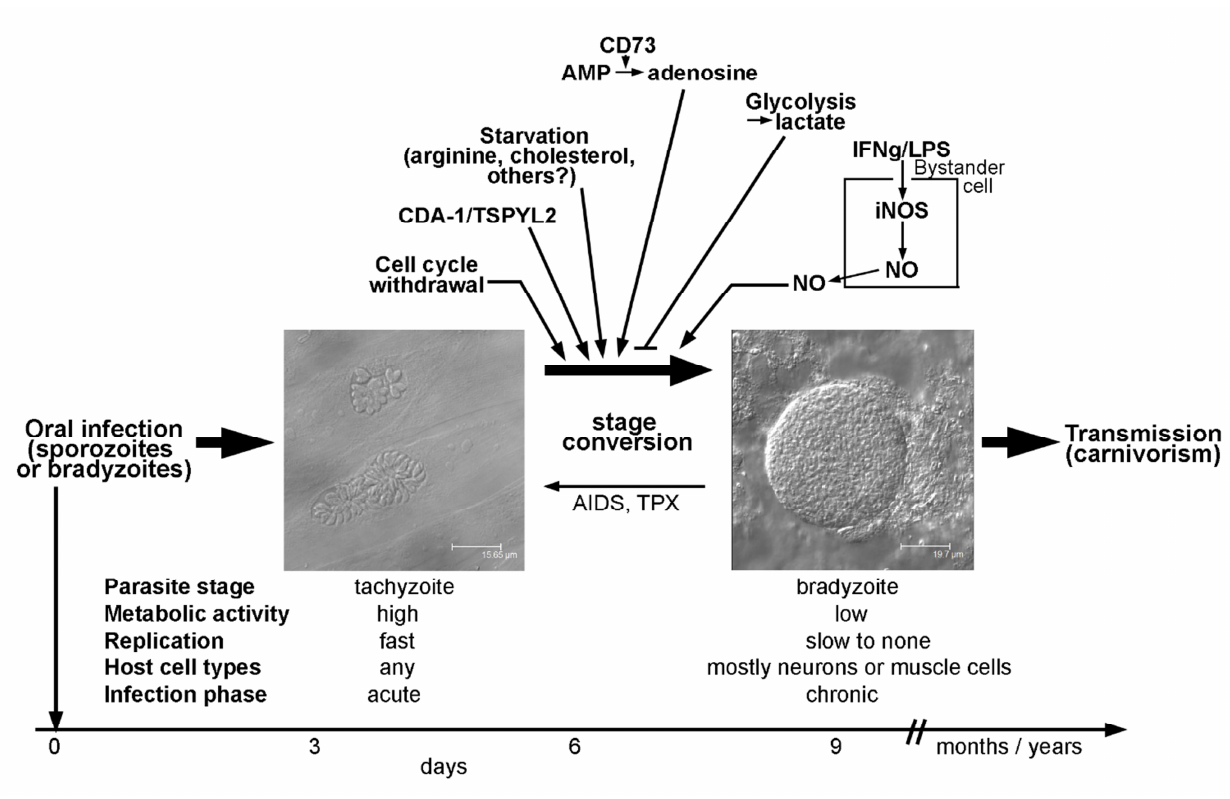
FIGURE 1: T. gondii stage conversion and its regulation by the host (cell) microenvironment. Within one to two weeks of infection, highly active tachyzoites (two parasitophorous vacuoles within human foreskin fibroblasts are depicted; left micrograph) convert to relatively dormant bradyzoites (a tissue cyst from mouse brain containing hundreds of individual bradyzoites is shown; right micrograph). Formation of long-lived bradyzoite-containing tissue cysts is crucial for parasite transmission to new hosts. Reconversion of bradyzoites to tachyzoites can occur in immunocompromised individuals (e.g. those with AIDS or transplant recipients (TPX)) leading to life-threatening disease. Dis- tinct characteristics of the infected host cell or of bystander cells can trigger or inhibit differentiation towards the bradyzoite stage as indi- cated in the upper part of the figure. Noteworthy, parasite-intrinsic triggers may also govern stage differentiation (not depicted). See main text for further